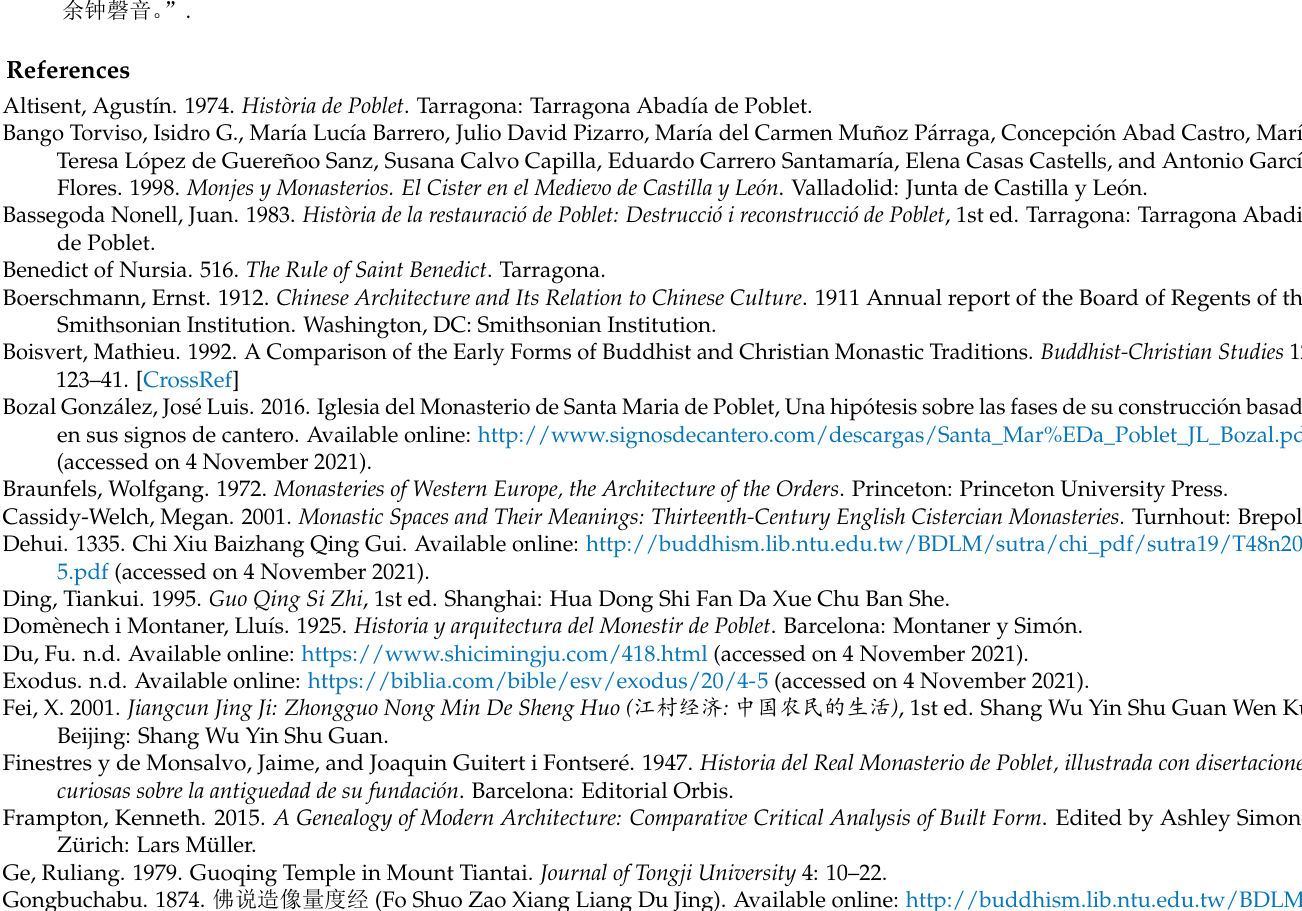
According to the Rule of Saint Benedict , there are four kinds of monks: Cenobites, Anchorites (or Hermits), Sarabaites and Landlopers. Although Guoqing Si belongs to Tiantai sect, it was converted to Chan Buddhist in Song Dynasty, and later changed back to Tiantai sect.